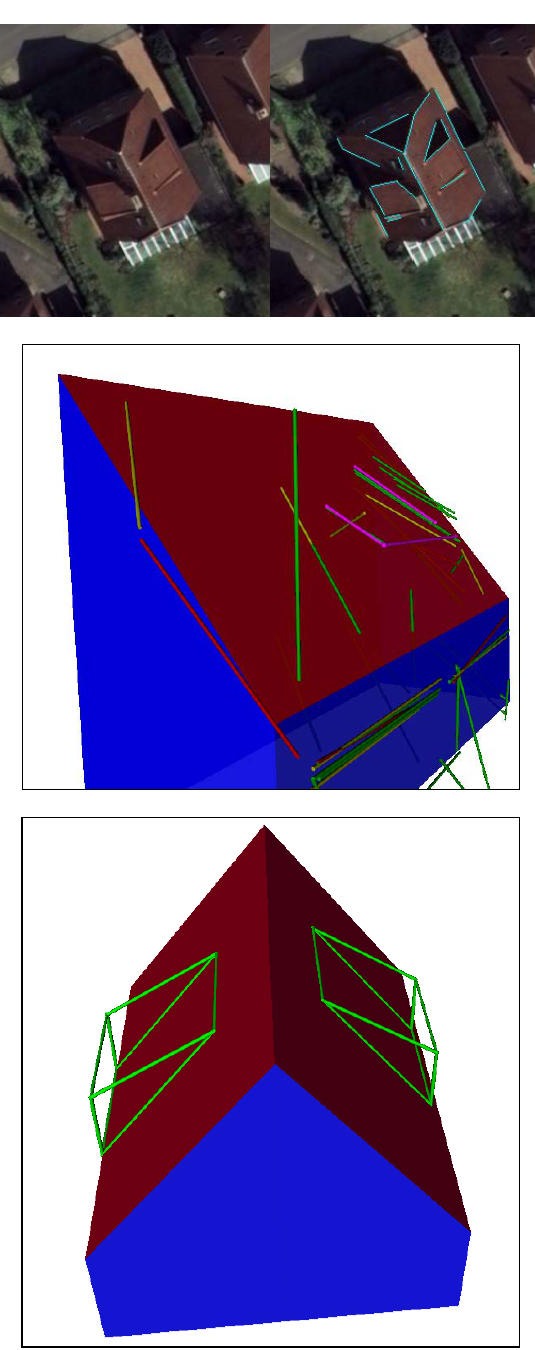
Figure 4. Steps within the Extraction of Roof Dormers. Top: Processed building in one perspective and the dormer based edge extraction. Middle: The set of 3D edges as candidates for dormer edges. Bottom: The selected dormer edges after the